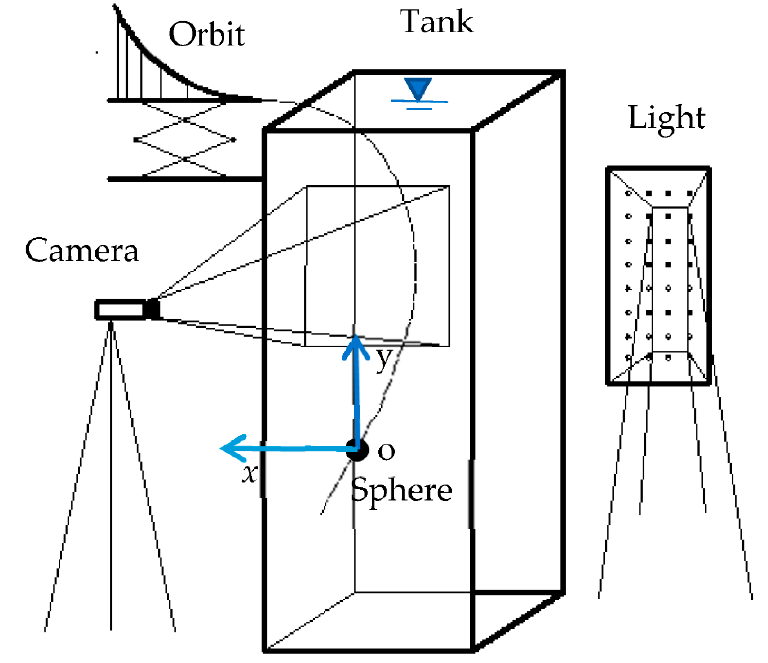
Figure 1. Schematic view of experimental setup.